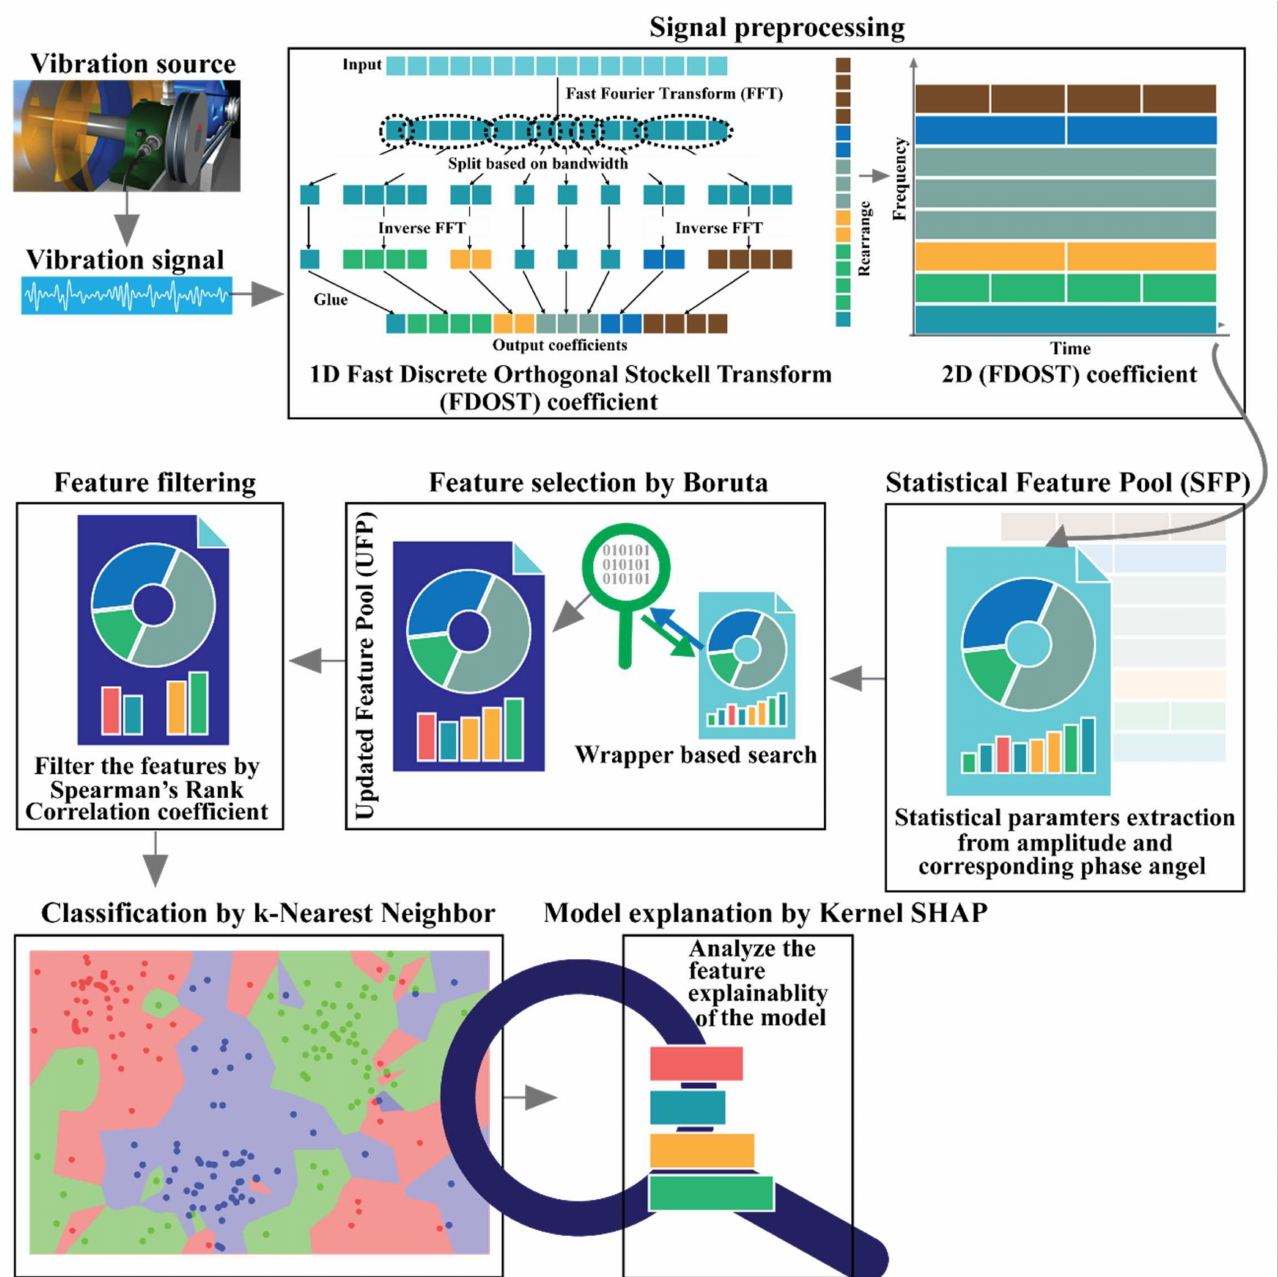
Figure 4. Block diagram of the proposed model for bearing fault